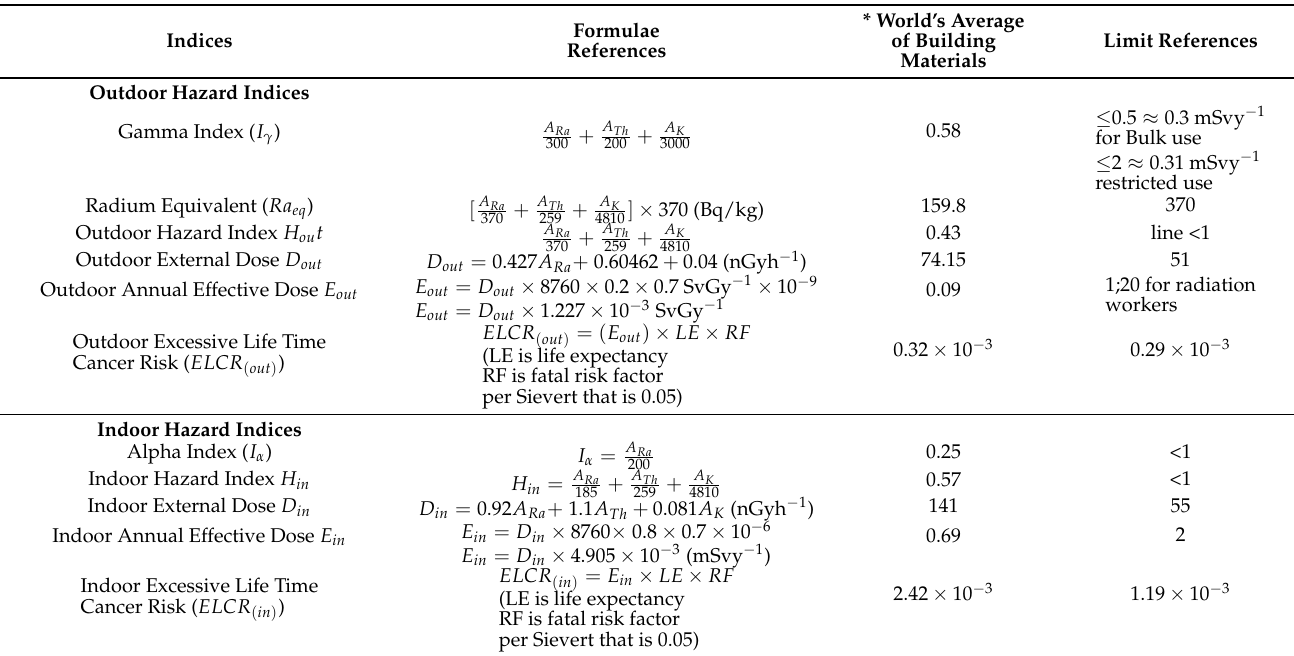
Table 2. Used formulas for the calculation of outdoor and indoor health hazards of Bajaur Norite. * World averages calculated by taking the averages of 226Ra, 232Th, and 40K as 50, 50, and 500 Bq per kg, respectively, in building materials (UNSCEAR) [2,12,15,19–22].